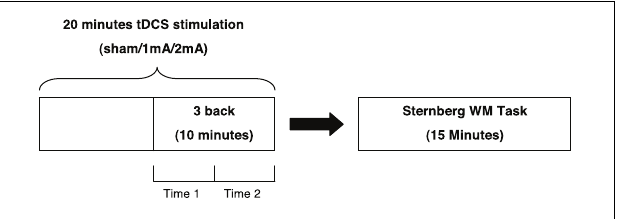
FIGURE 1 |The experimental protocol